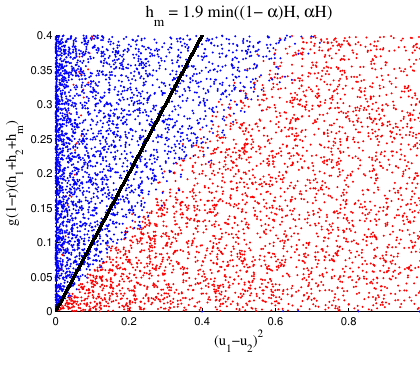
Figure 15. The same as in Figures 13 and 14 but with h m = 1 . 9min((1 − α ) H,αH